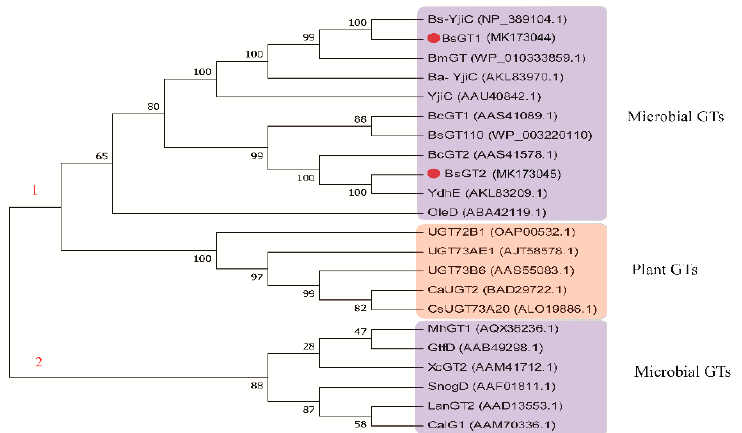
Figure 5. Phylogenetic analysis of BsGT1 , BsGT2 , and 20 GTs from plants, bacteria, and fungi. The tree, whose substitution model was Poisson correction, was constructed with the neighbor-joining method based on 1000 bootstrapping cycles. Black numbers at each branch point represent the bootstrap values in the form of percentage. The sequences’ GenBank accession numbers are also given.